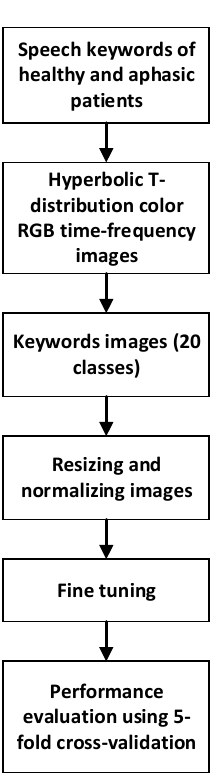
Figure 1. Performance evaluation of the CNN model which utilizes hyperbolic T-distribution RGB color time-frequency images.